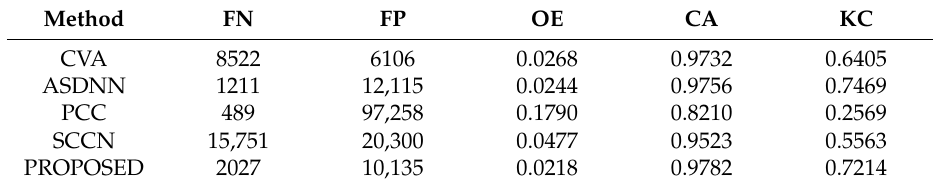
Table 4. Values of the evaluation criteria on the Shuguang Village dataset by different